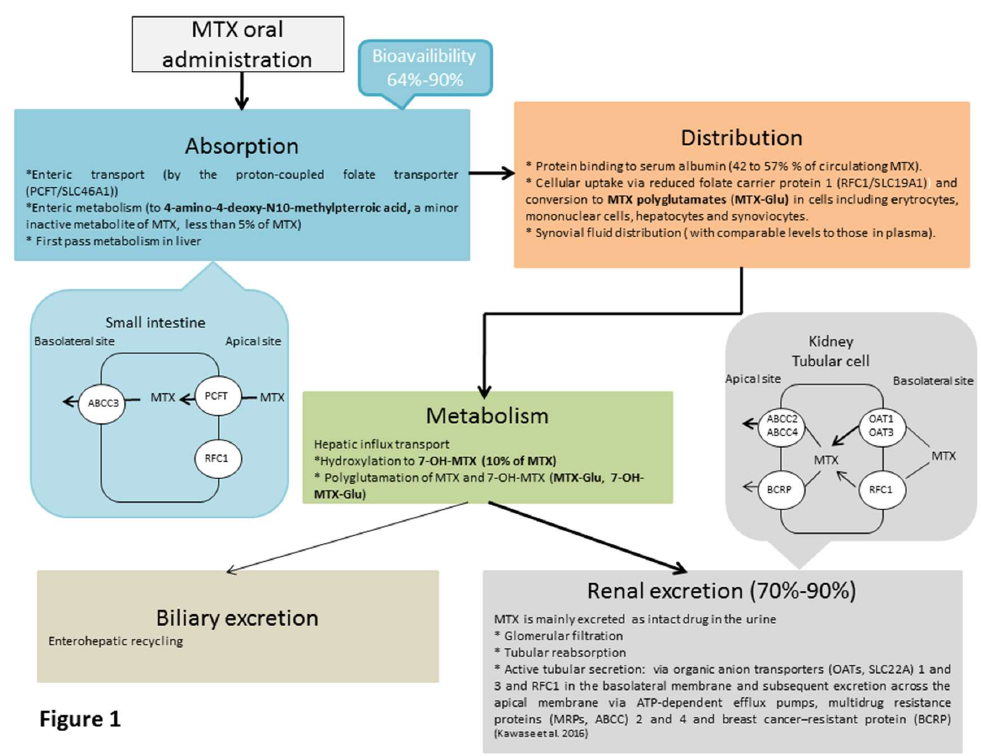
Figure 1. Pharmacokinetic process of MTX after oral administration. MTX absorption, distribution, metabolism, and excretion after oral administration.